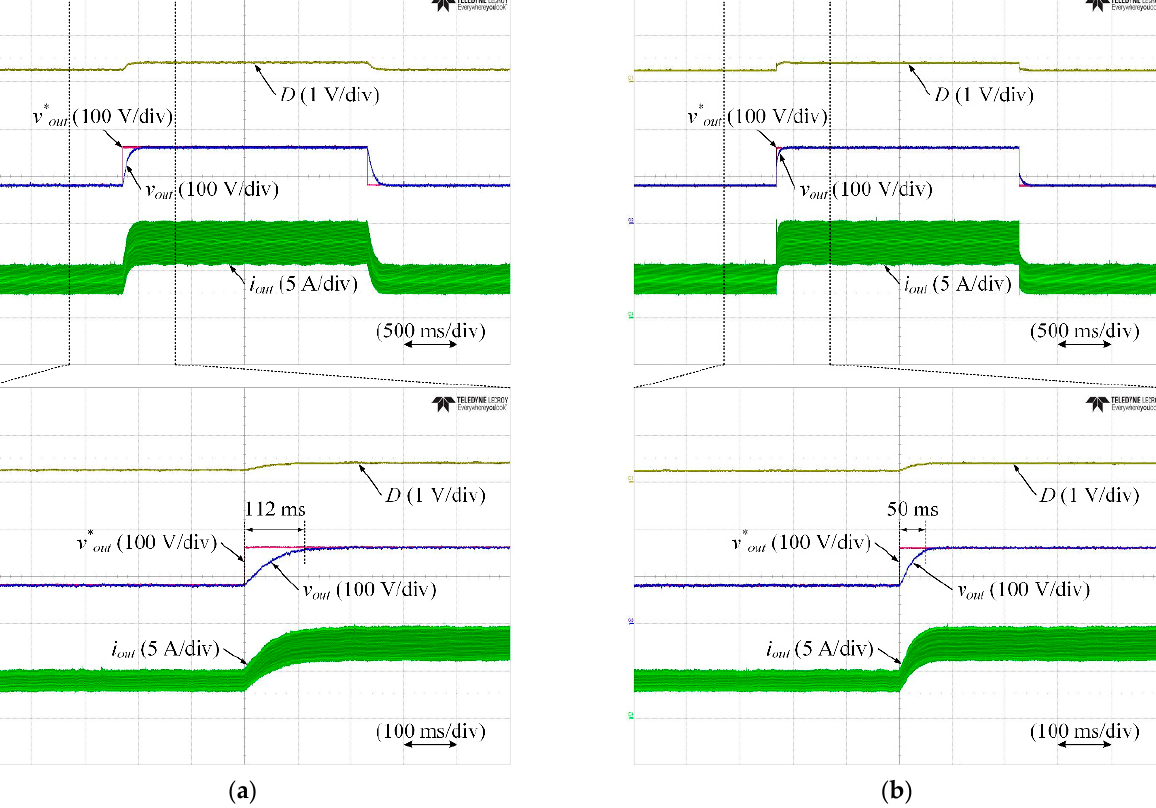
Figure 15. Experimental results of output voltage control of integrated OBC using ( a ) PI control and ( b ) the proposed MPC method.